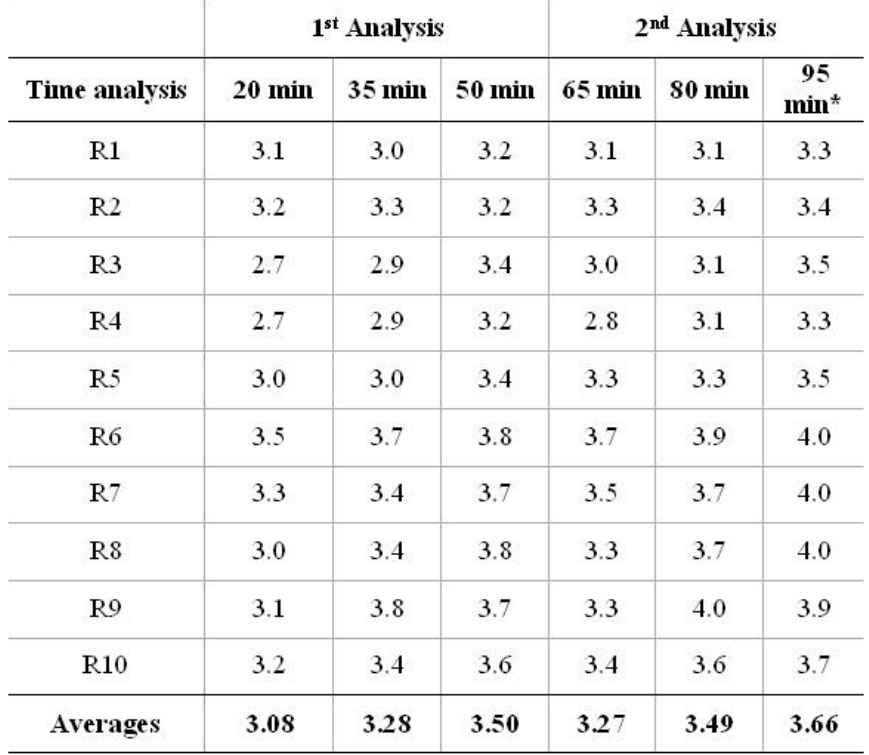
TABLE 2 – K + values in the first and second gasometrical analysis during the blood storage on